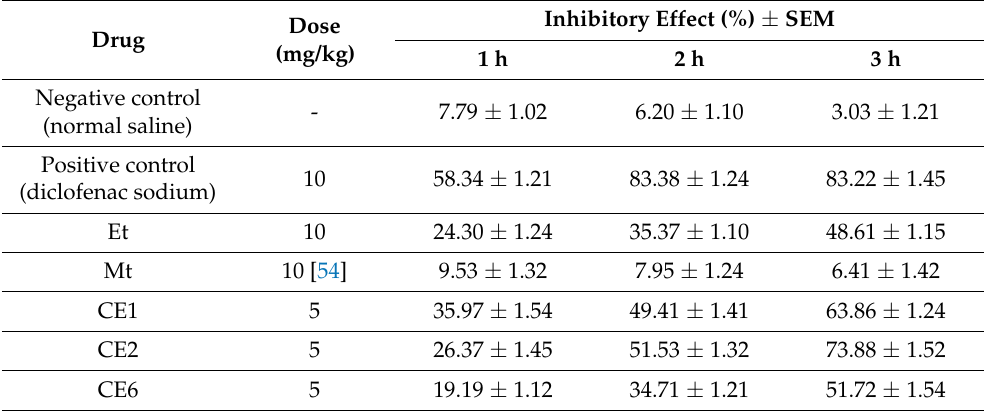
Table 5. In vivo analgesic